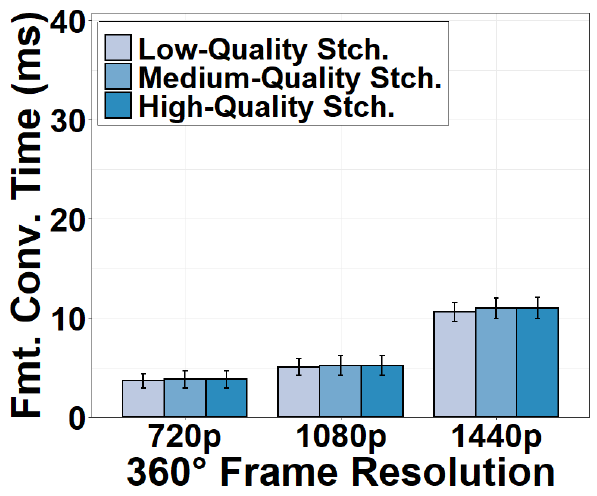
Figure 7. Format conversion time versus stitching